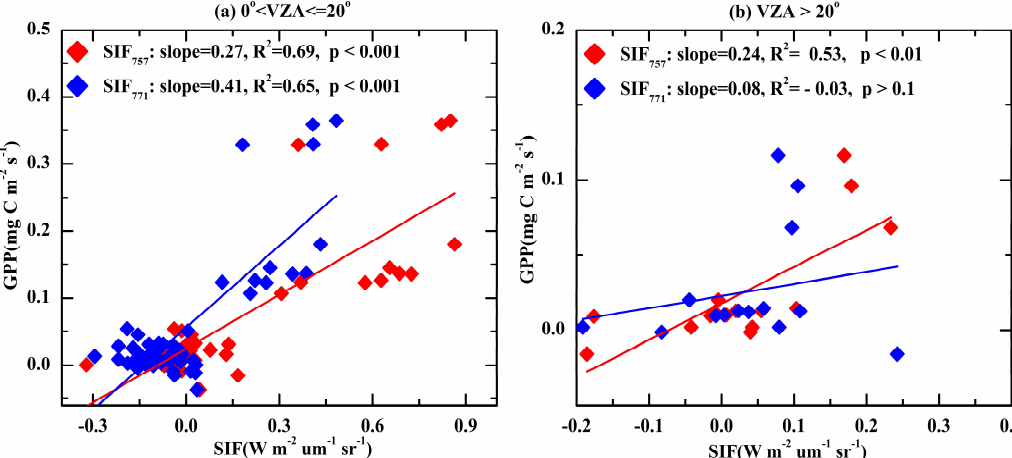
Figure 8. Effects of the VZA on the relationships between the OCO-2 SIF and tower GPP at an instantaneous timescale: ( a ) the relationship between the tower GPP and OCO-2 SIF in the interval of 0° < VZA ≤ 20° at the Daman and A’rou sites; ( b ) the relationship between the tower GPP and OCO-2 SIF in the interval of VZA > 20° at the Daman and A’rou sites.